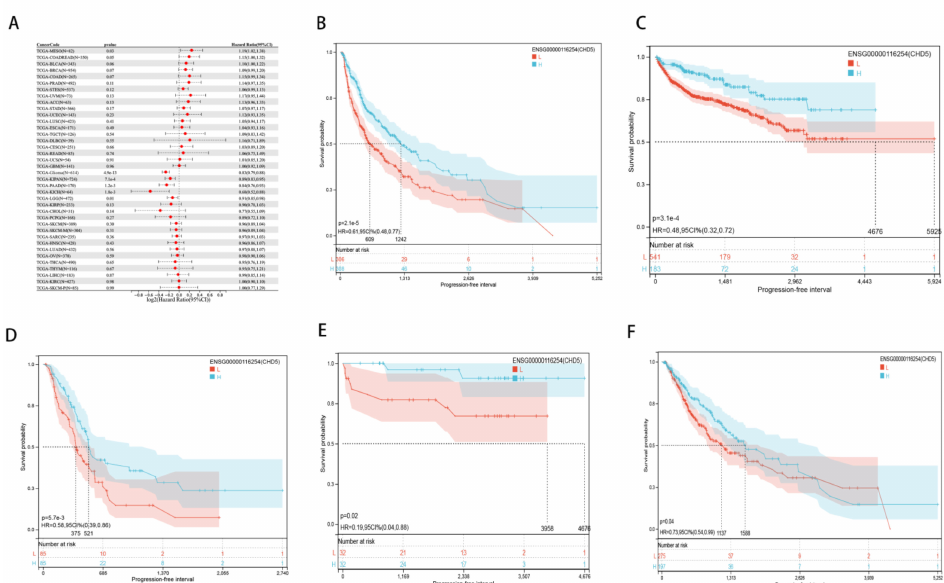
Figure A2. Correlation between CHD5 expression and disease-free interval (DFI). ( A ) Forest plots showing the relationship between CHD5 expression and DFI in 44 tumor types. Kaplan-Meier analyses of the association between CHD5 expression and DFI in ( B ) Glioma, ( C ) Pan-kidney cohort (KICH+KIRC+KIRP) (KIPAN), ( D ) Pancreatic adenocarcinoma (PAAD), ( E ) Kidney Chromophobe (KICH), ( F ) low grade glioma